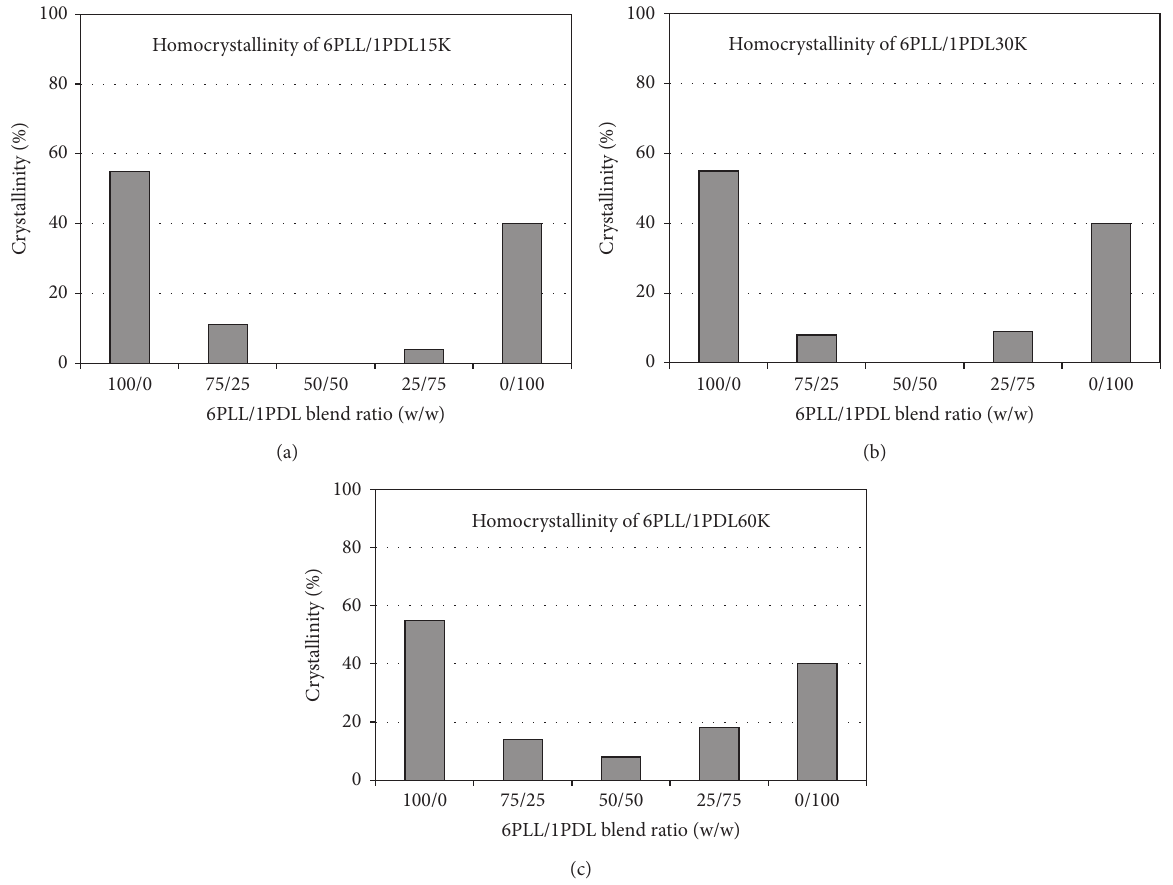
Figure 2: Homocrystallinity of 6PLL, 1PDL, and their polylactide stereocomplexes prepared with different 1PDL molecular weights and 6PLL/1PDL blend